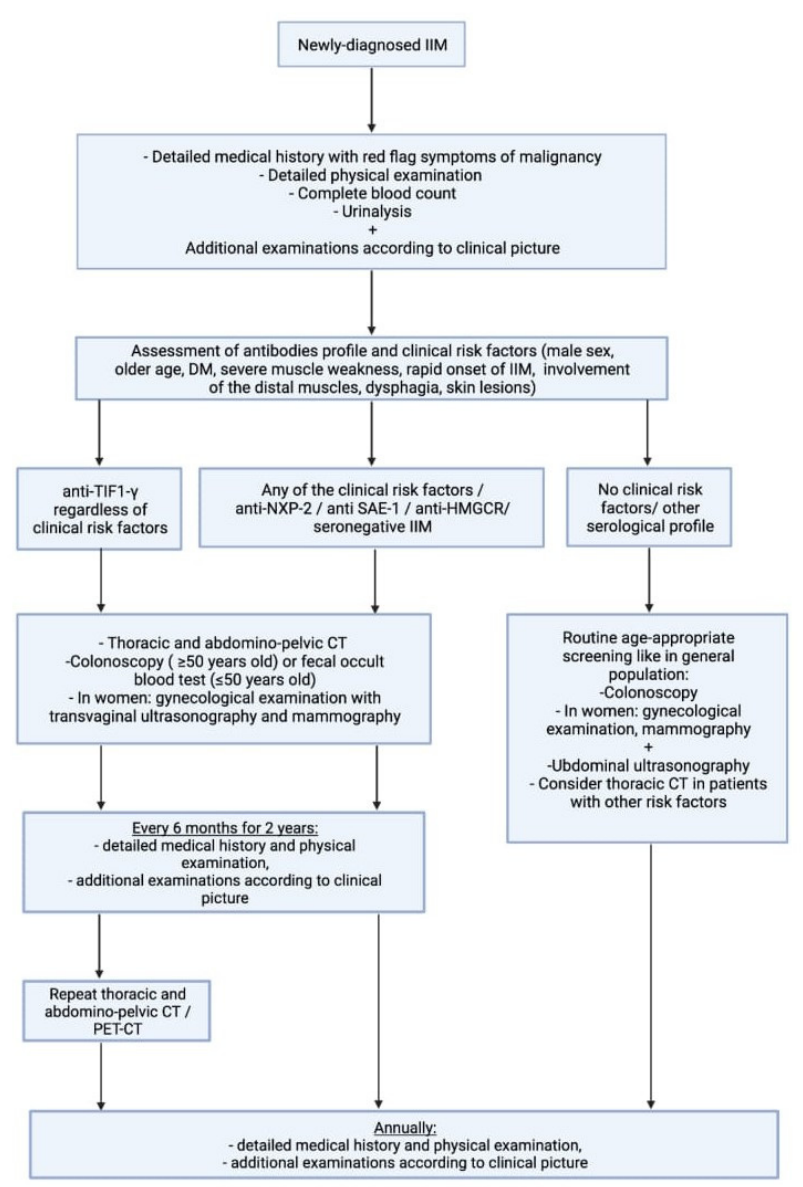
Figure 3. Proposed scheme for cancer screening. IIM-idiopathic inflammatory myopathy, PET- positron emission tomography, CT-computed tomography.